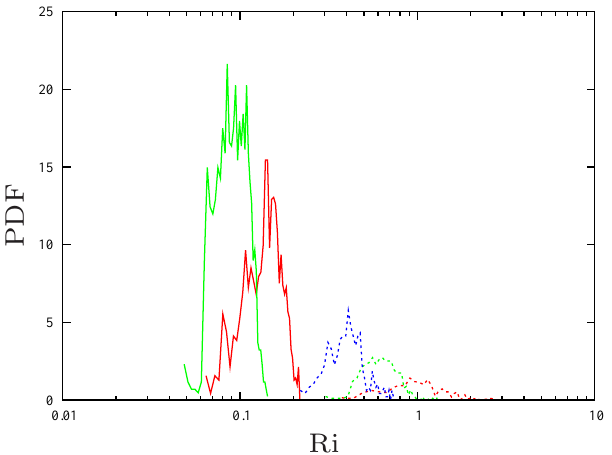
Figure 8. PDF of Ri for the weak forcing cases (red lines); moderate forcing cases (green lines); and strong forcing case (blue line). Solid lines: 1 = 2m; dotted lines: 1 = 10m.